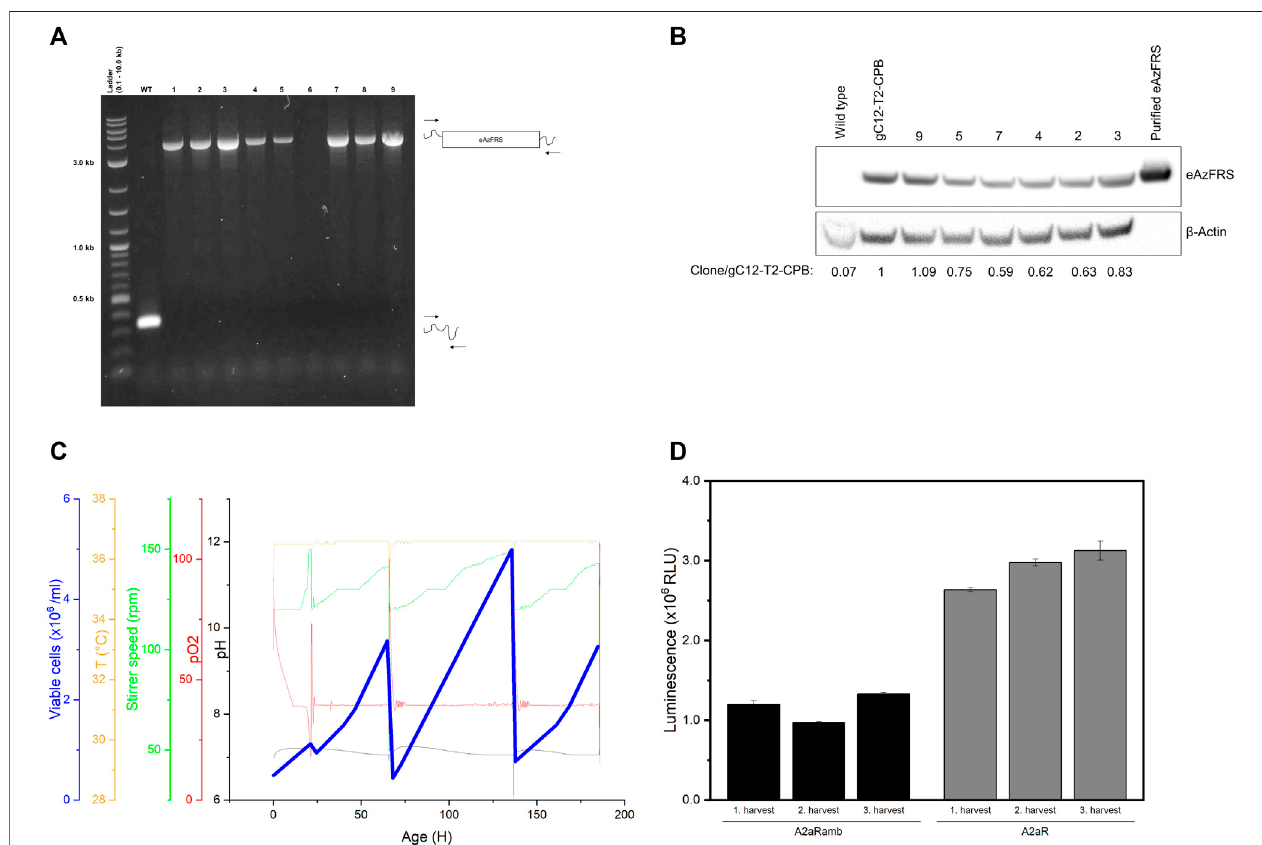
FIGURE 5 | Evaluation of clonal cell lines expressing the eAzFRS. (A) Genotyping PCR of clonal cell lines isolated from clone pool gC12-T2-CPB. The expected outcome is indicated by visualize primer binding (arrows) on wilde type (WT) and modi fi ed cells. A Quick-Load 2-Log DNA Ladder 0.1 – 10.0 kb (New England Biolabs) was used. (B) Semi-quantitative western blot of cell clones. eAzFRS band intensities were normalized to the internal β -Actin control. The indicated fold change is expressed asratioofband intensity ofthe samples compared toclone pool gC12-T2-CPB. (C) Exemplary fermentation process ofclone RS7.Cell harvesting was performedthreetimesathighestpeaks(blueline). (D) Luciferaseassayofcell-freesynthesizedA2aRandA2aRambconstructsbasedoncelllysatespreparedfromthree harvest points of a cultivation process using CHO clone RS7. Experiments were performed in technical triplicates and bars represent the standard